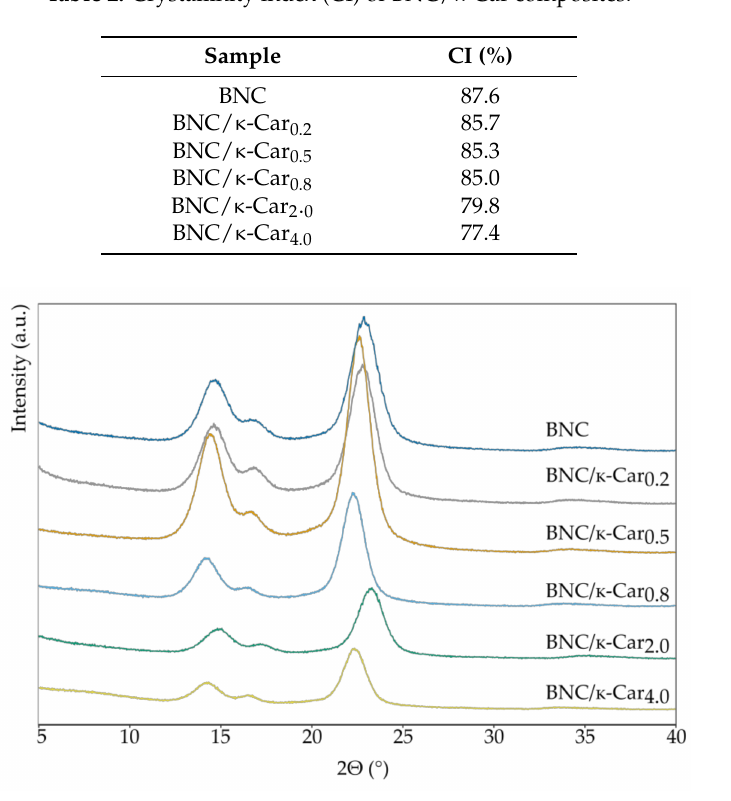
Table 2. Crystallinity index (CI) of BNC/ κ -Car composites.